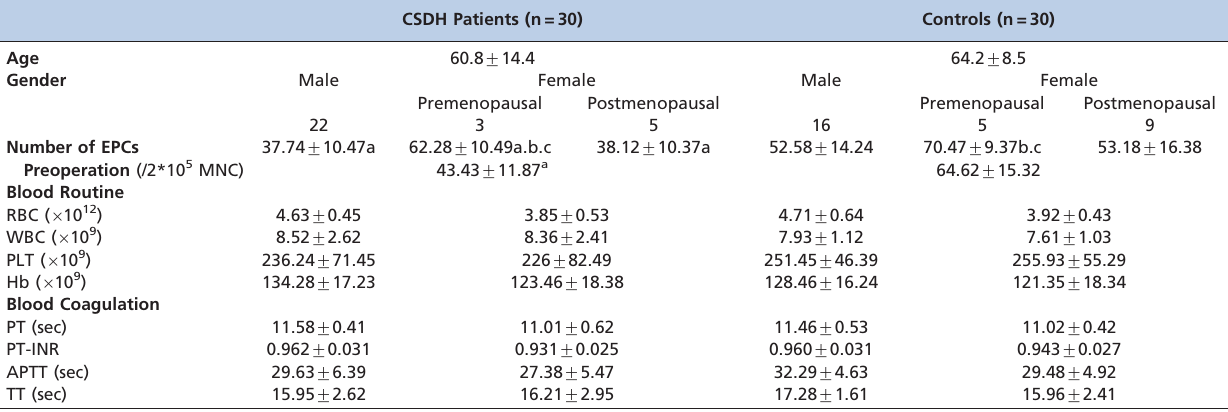
Table 1 - Laboratory characteristics of patients and